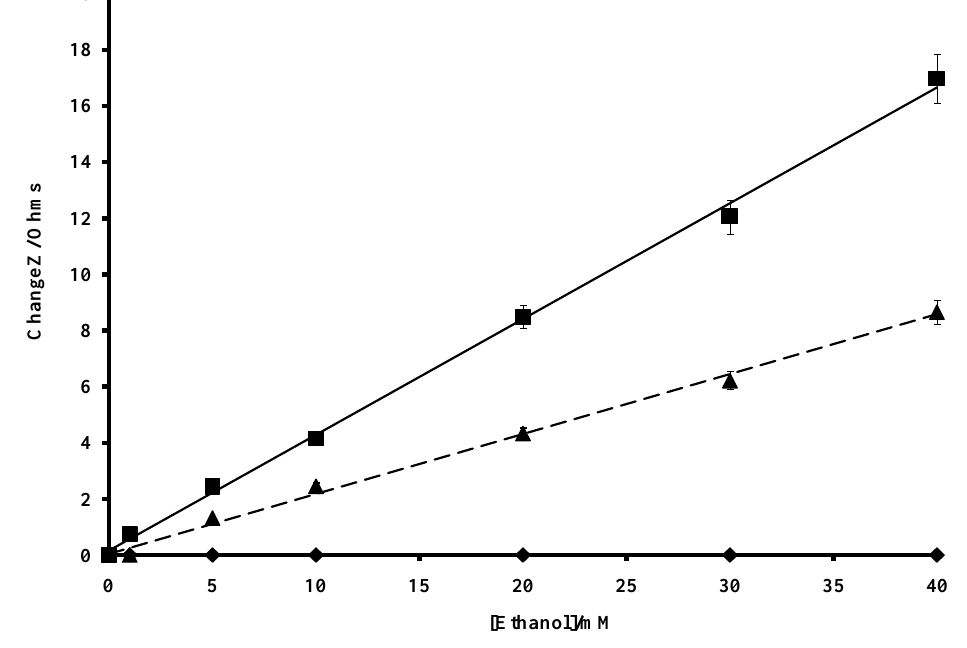
Figure 13. Calibration plot for impedance changes (at 0.1 Hz) for a poly(aniline)/alcohol oxidase microelectrode array versus ethanol concentration under; (a) aerobic (  ) and (b) anaerobic (  ) conditions (c) control experiment with an enzyme free microelectrode array ( 